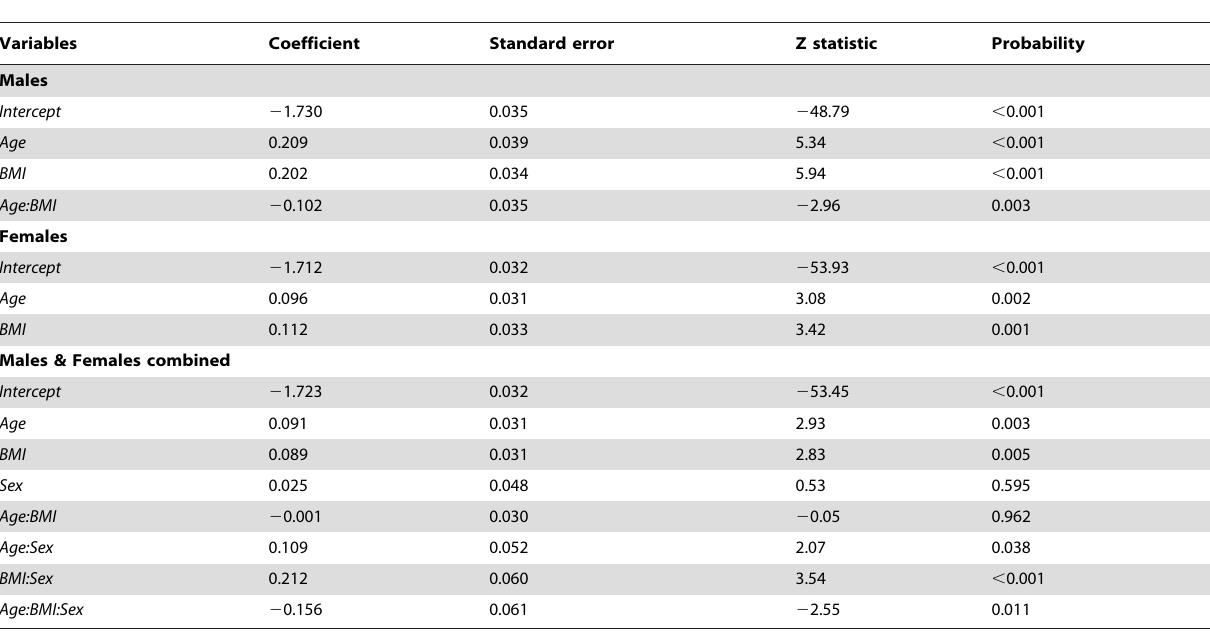
Table 6. Coefficients showing the influence of age, BMI and sex on platelet microparticles.